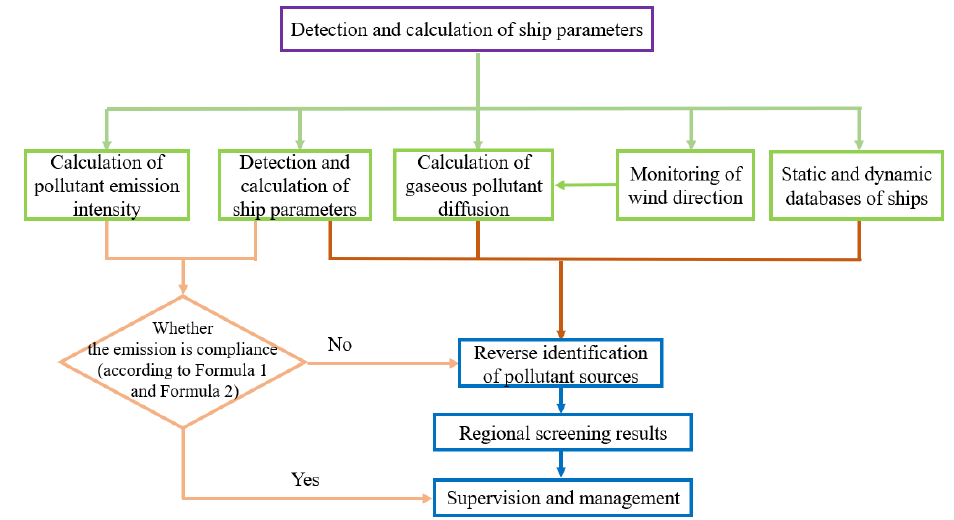
Figure 9. Algorithm flow of compliance judgment, screening, and supervision of voyaging ships.